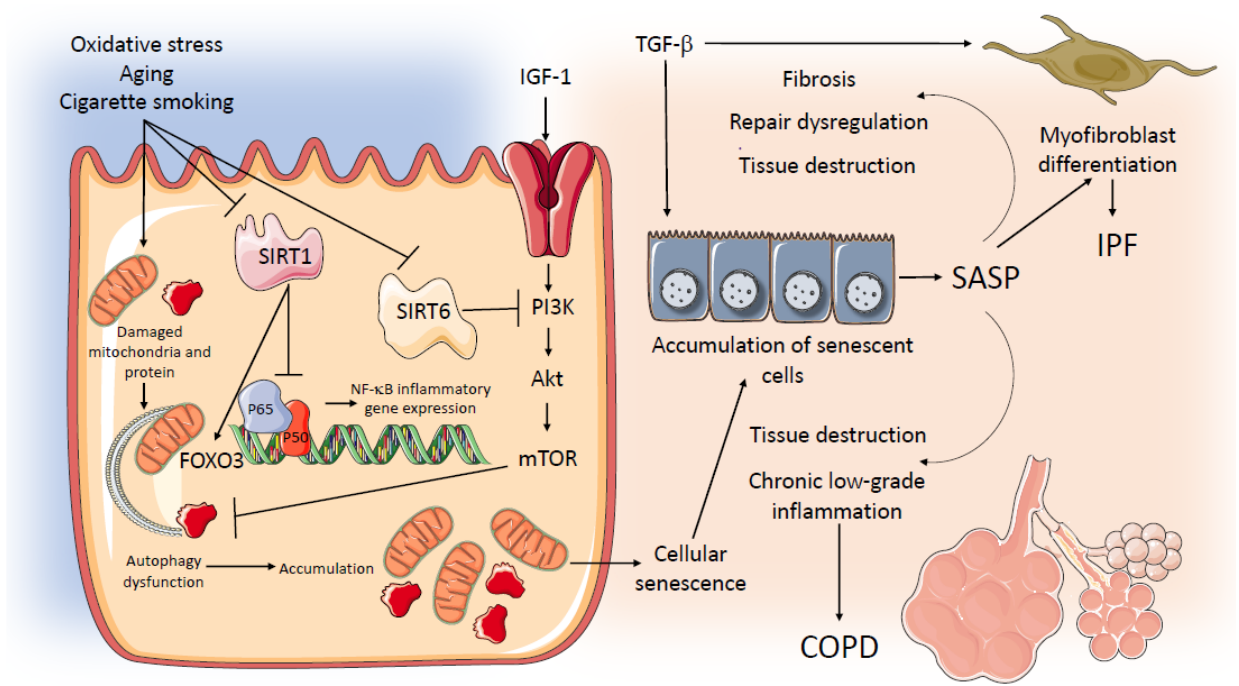
Figure 2. Potential common mechanisms related to aging and senescence operating in IPF and COPD. AKT: serine/threonine kinase; COPD: Chronic Obstructive Pulmonary Disease; FOXO 3: Forkhead Box O3; HBEC: human bronchial epithelial cells; IPF: Idiopathic Pulmonary Fibrosis; IGF ‐ 1: Insulin Growth factor 1; mTOR: Mechanistic Target of Rapamycin; NF ‐ kB: nuclear factor kappa ‐ light ‐ chain ‐ enhancer of activated B cells; PI3K: phosphoinositide 3 ‐ kinase; SASP: senescence ‐ associated secretory phenotype; SIRT 1: Sirtuin ‐ 1; SIRT 6: Sirtuin ‐ 6; TGF β : Transforming Growth Factor β .